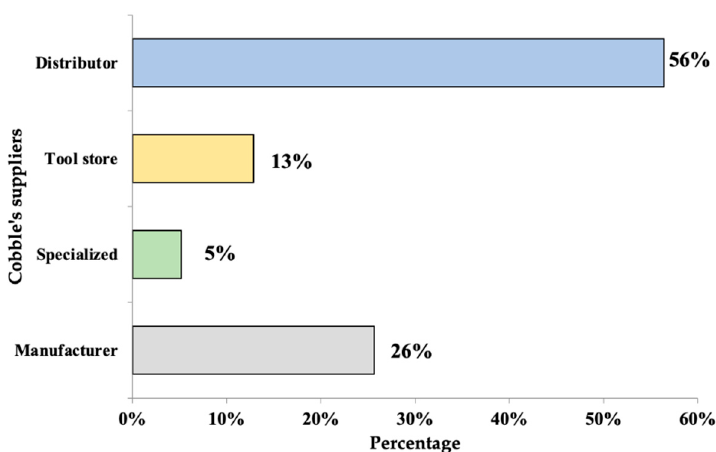
Figure 7. Suppliers of cobbles for pedestrians use in entities interviewed in Ibagué.